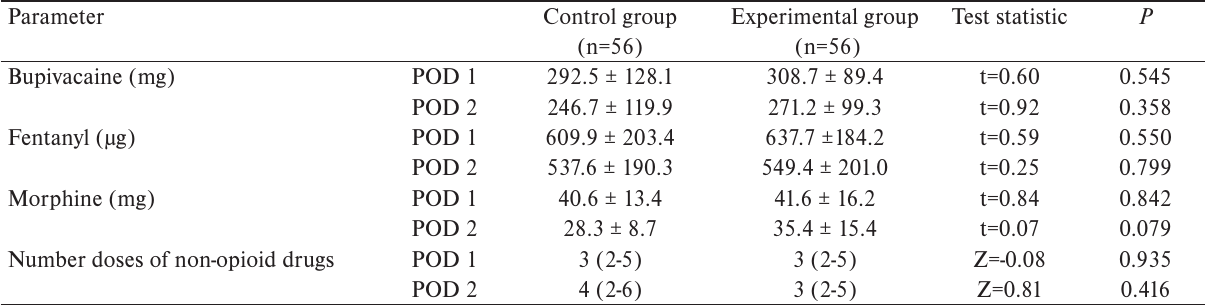
Table 2. Comparison of patients from the control and experimental group in terms of drugs consumption by postoperative day. Parameter